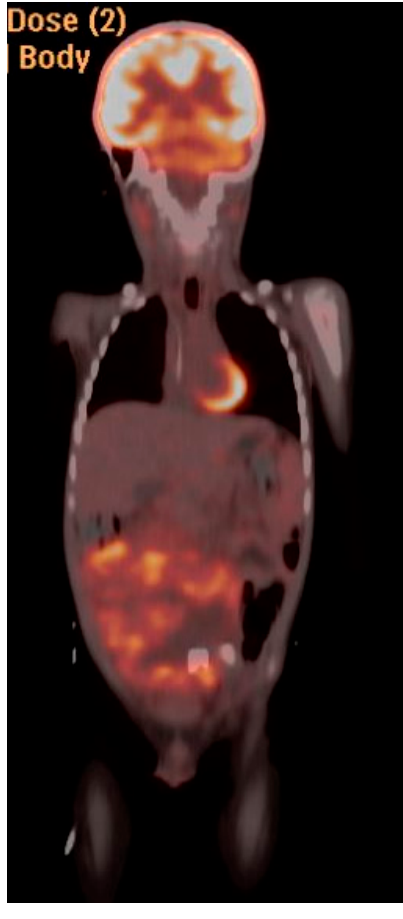
Figure 10. PET CT coronal view of intraabdominal Ewing sarcoma.